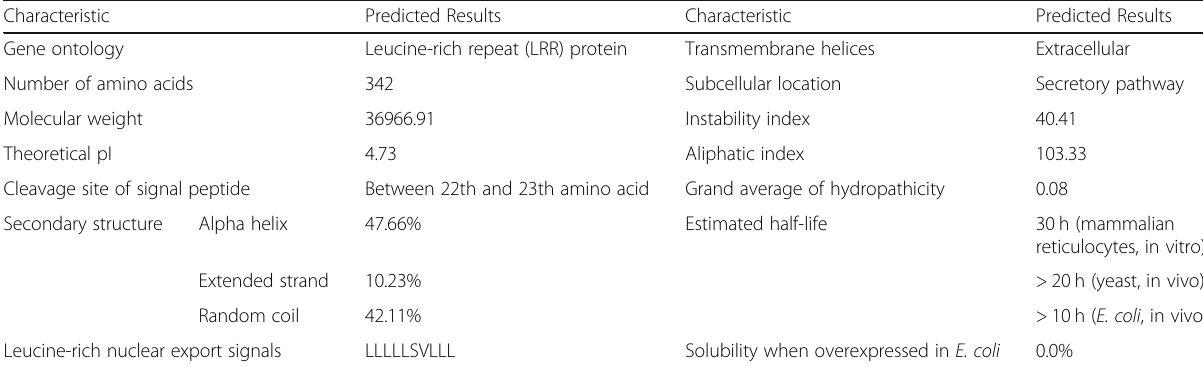
Table 1 Characterization of deduced OsPGIP2 protein